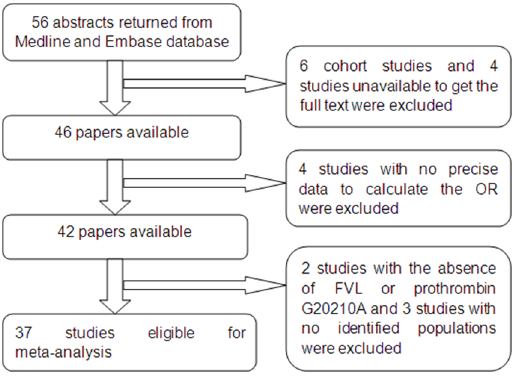
Figure 1. Flow diagram of meta-analysis literature search results.